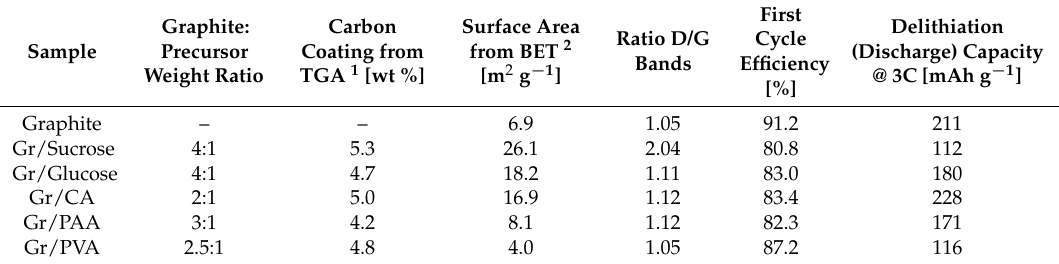
Table 2. Characteristic of pristine and coated samples and electrodes: graphite:precursor weight ratios, carbon coating fraction, surface area, D/G band ratio, first cycle efficiency and delivered discharge capacity at